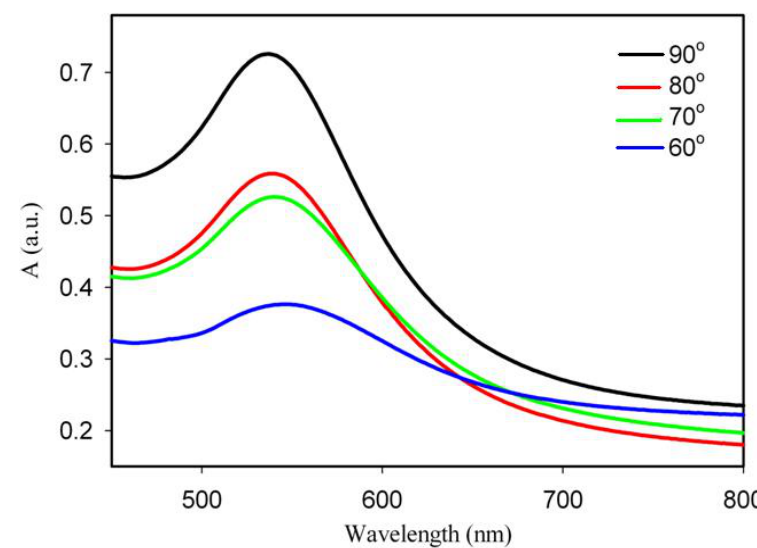
Figure 3. Dependence of the absorbance of Au LSPR band on the annealing temperature (time of irradiation is kept constant at 90